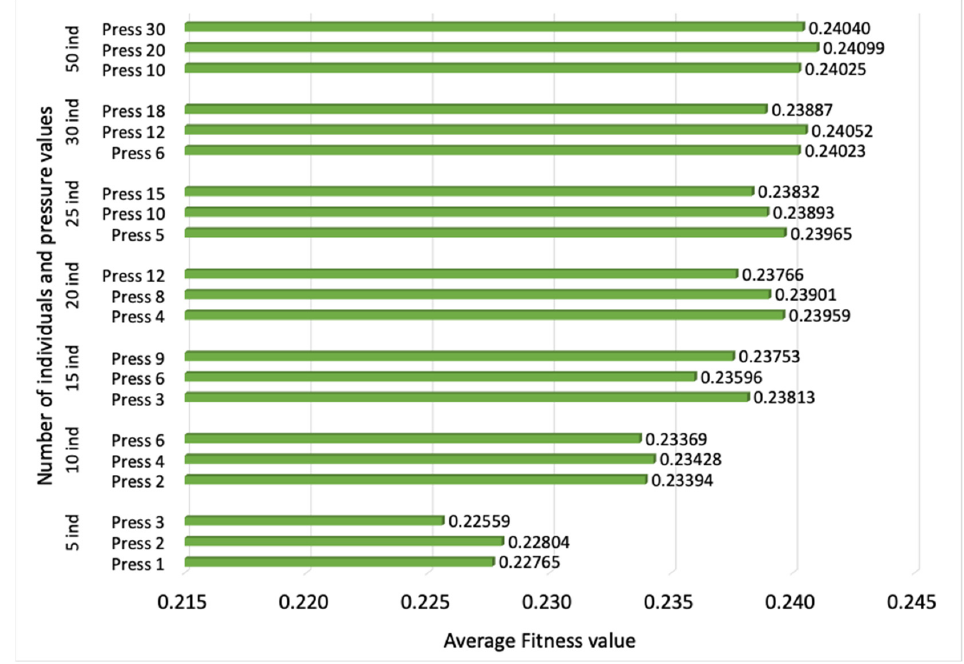
Figure 3. Average fitness value of the best individual for populations built of different number P of individuals and pressure values.